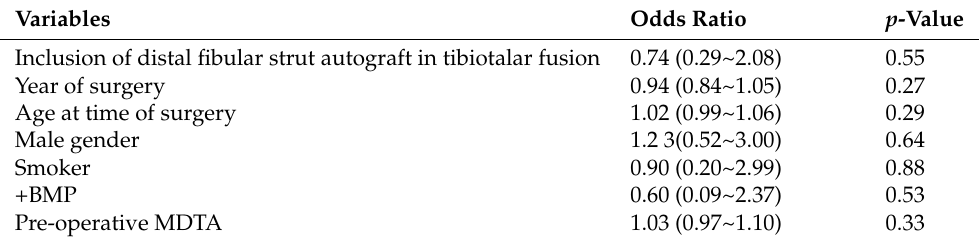
Table 10. Multivariable logistic regression predicting